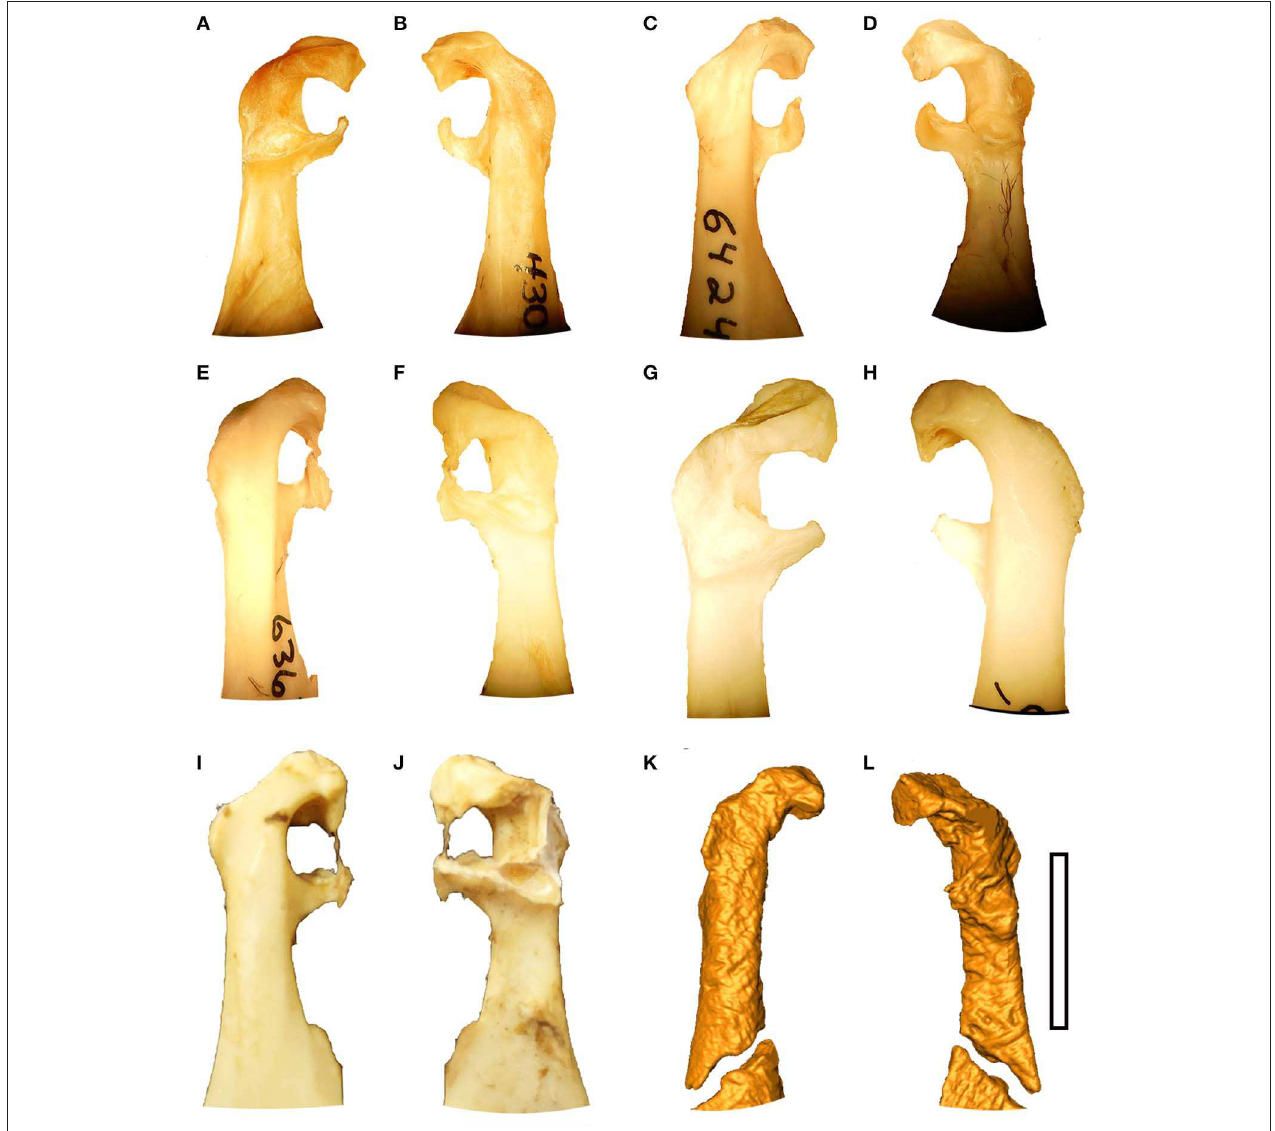
FIGURE 6 | Coracoid morphology of the new species Linxiavis inaquosus in comparison to extant species of Pterocles . (A,B) P. burchelli (USNM 430845); (C,D) P. namaqua (USNM 64231); (E,F) P. decoratus (USNM 636741); (G,H) P. orentalis (USNM 344845); (I,J) S. paradoxus (IVPP OV973); (K,L) Linxiavis inaquosus. Scale bar equals